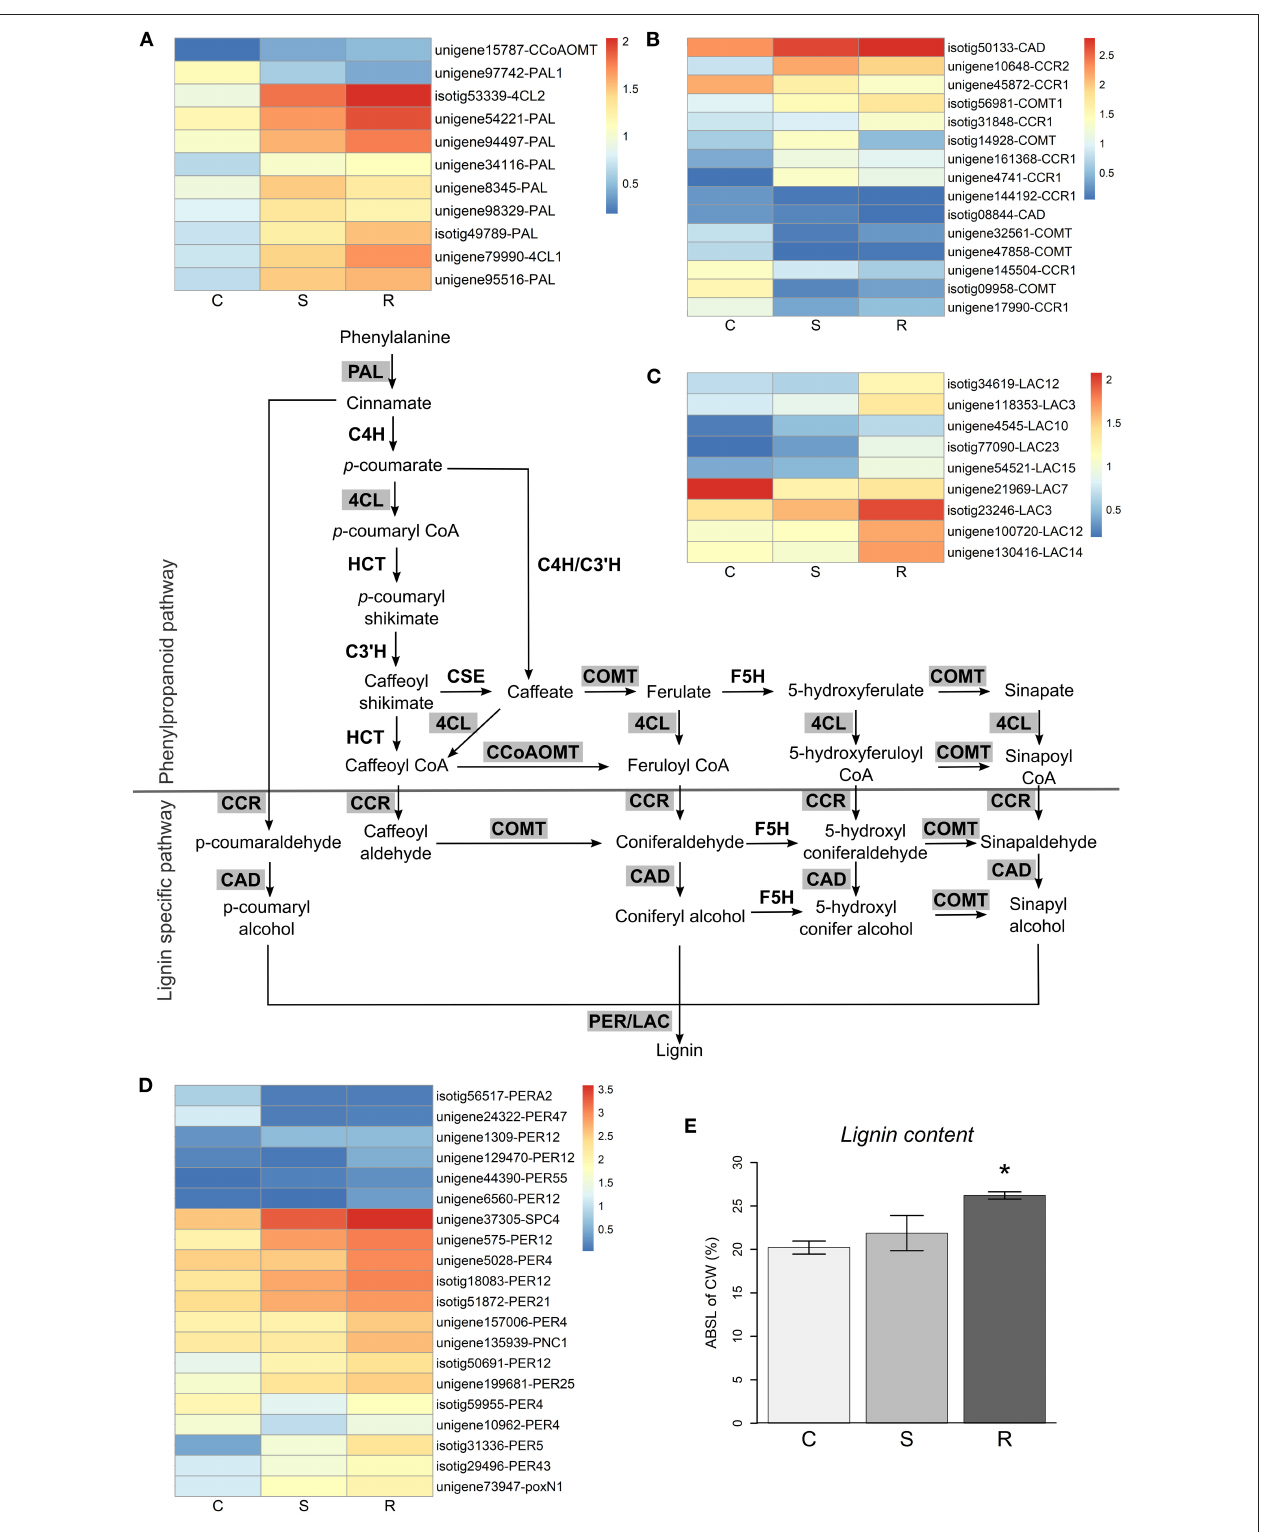
FIGURE 5 | Lignin biosynthesis pathway. Lignin biosynthesis pathway is represented (adapted from Xie et al., 2018), with the differential expressed genes highlighted in gray. Heatmaps represent log10(TPM) values of differentially expressed genes in the general phenylpropanoid pathway (A) and the lignin specific pathway (B–D) . The final steps of